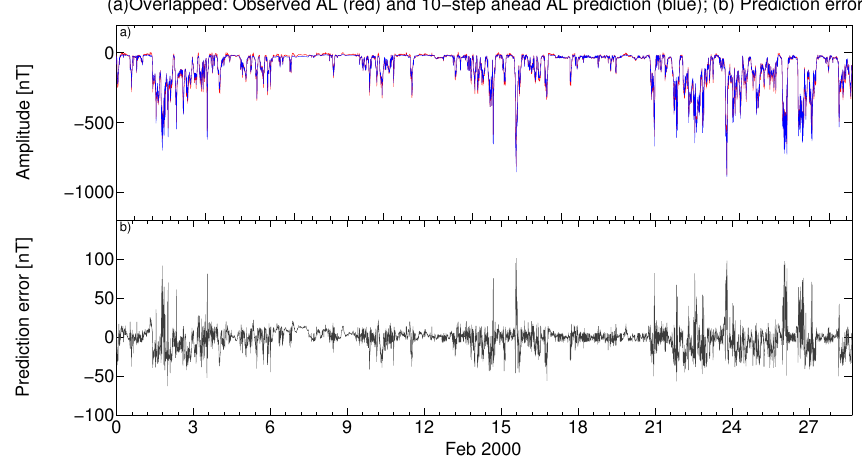
Fig. 5. (a) AL observation (red) and predicted AL (blue) – 10 step ahead prediction; (b) prediction error. The panel shows one month of data (February 2000) at 1min